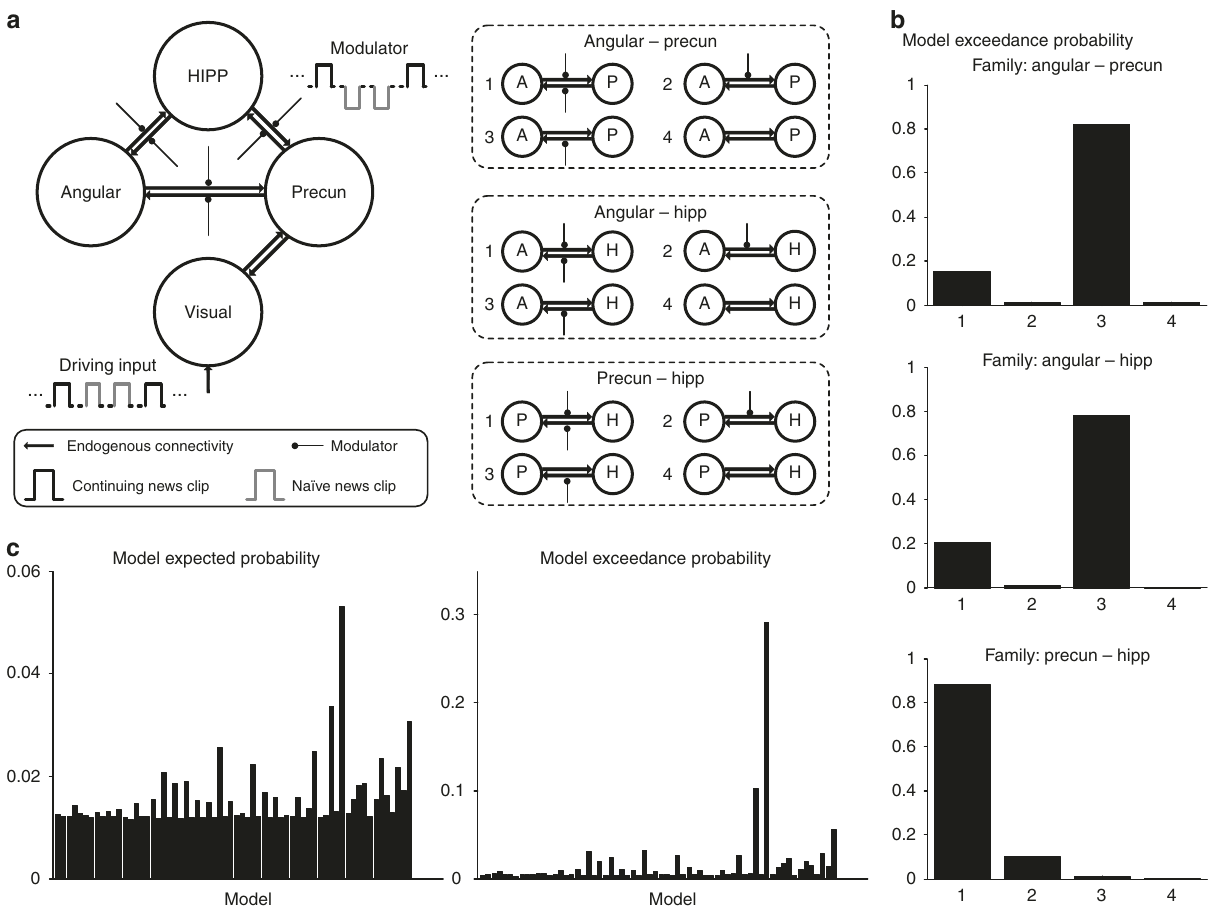
Fig. 3 DCM analyses of modulations for the second news viewing. The models are speci fi ed by adding modulations corresponding to the continued-viewing effect. a Identi fi cations of the model space in terms of three sets of modulator families, including modulator acting on connections between angular gyrus and precuneus, angular gyrus and hippocampus, precuneus and hippocampus, resulting in 64 competing models. b Exceedance probability (right) for the DCM model families in the BMS, including angular gyrus – precuneus families, and angular gyrus – hippocampus families, precuneus – hippocampus families. The label of horizontal axis for each box corresponds to the label in ( a ). c Results of the BMS across all the 64 models. HIPP = Hippocampus; Precun = Precuneus; Angular = Angular